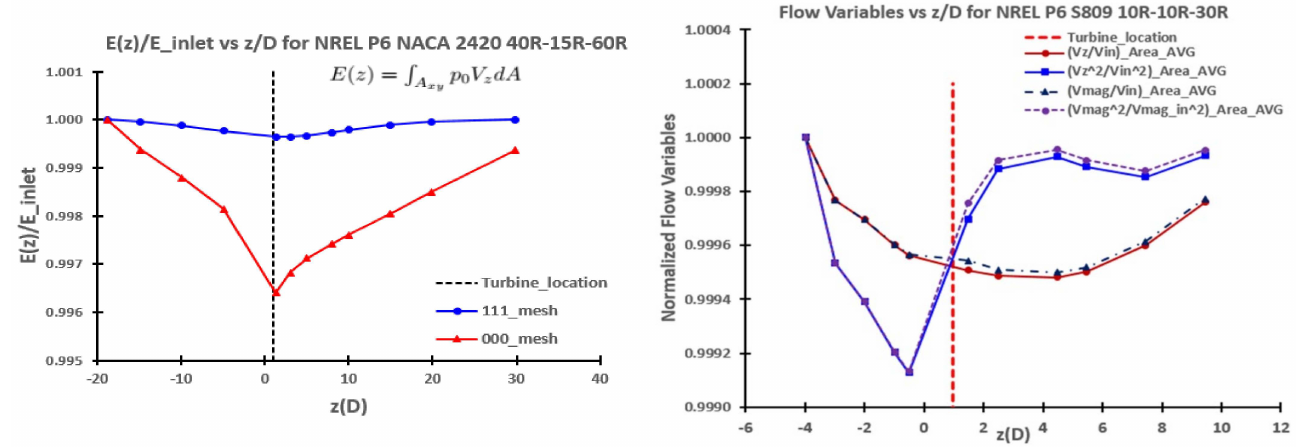
Figure 34. Kinetic energy downstream of the wind turbine rotor for 4X domain with coarse and fine mesh ( left ) and normalized velocity and kinetic energy showing energy transfer and mixing of the flow ( right